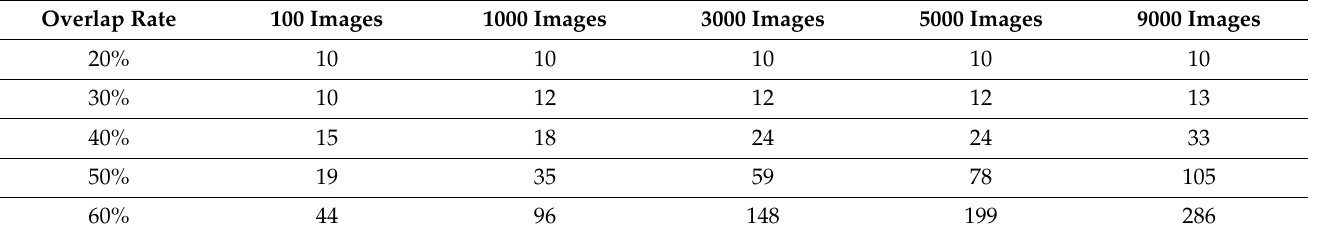
Table 2. Number of memory patterns compared to SDR overlapping rate.